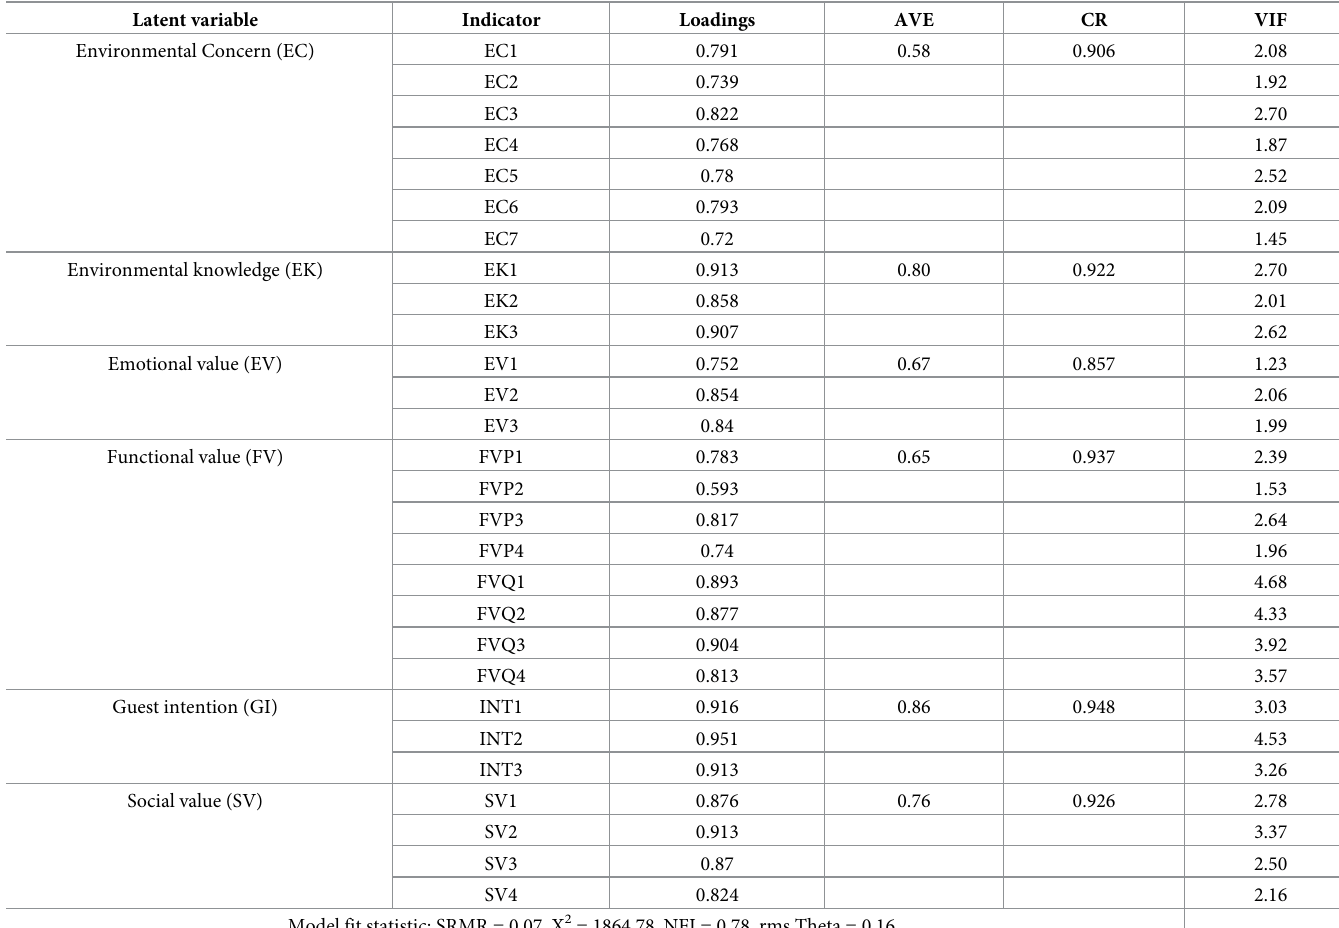
Table 3. Validity and reliability for construct.